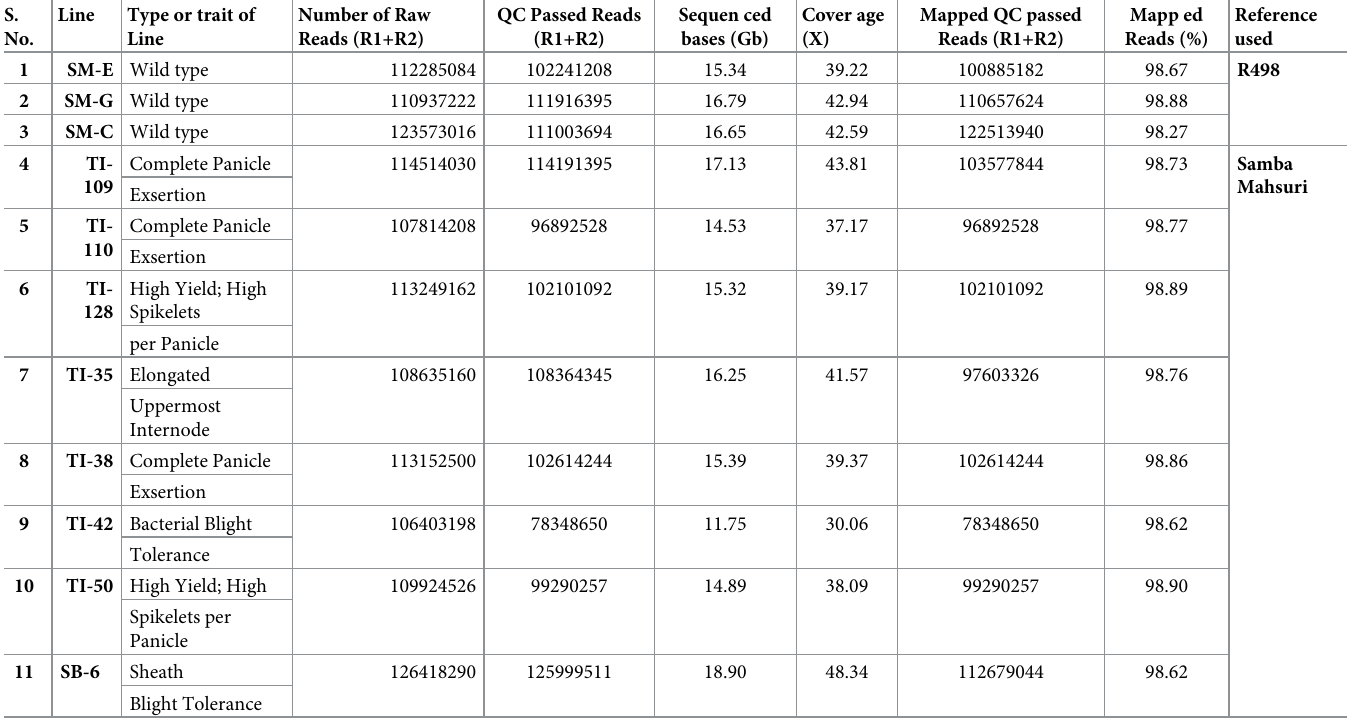
Table 3. Sequence statistics of Samba Mahsuri (wild type) and mutant lines with different traits.